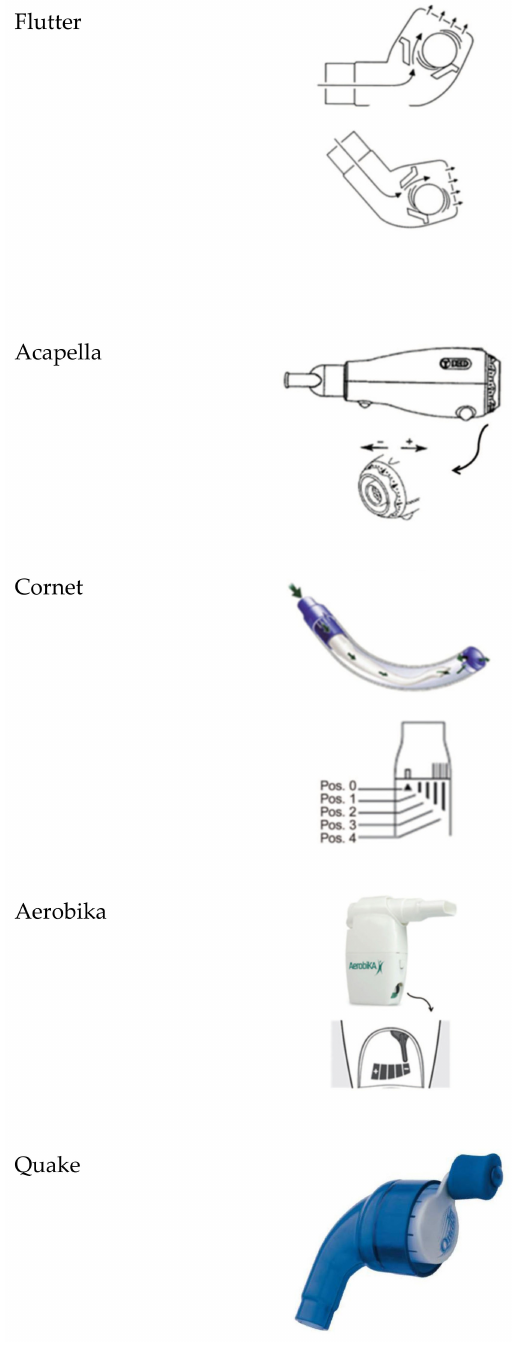
Figure 1. Oscillating